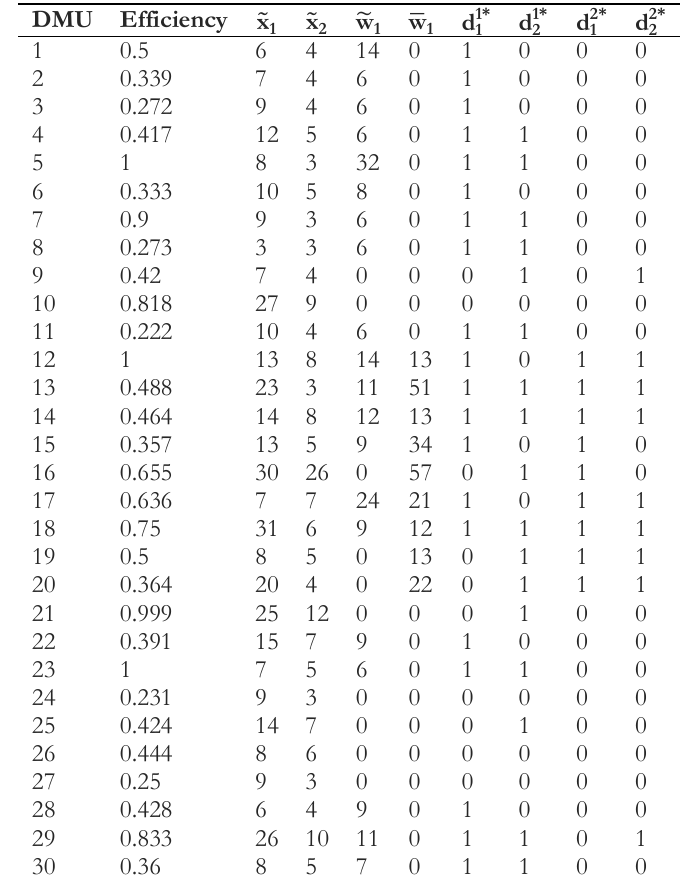
Table 2. The results obtained from the (IFNDEA) model